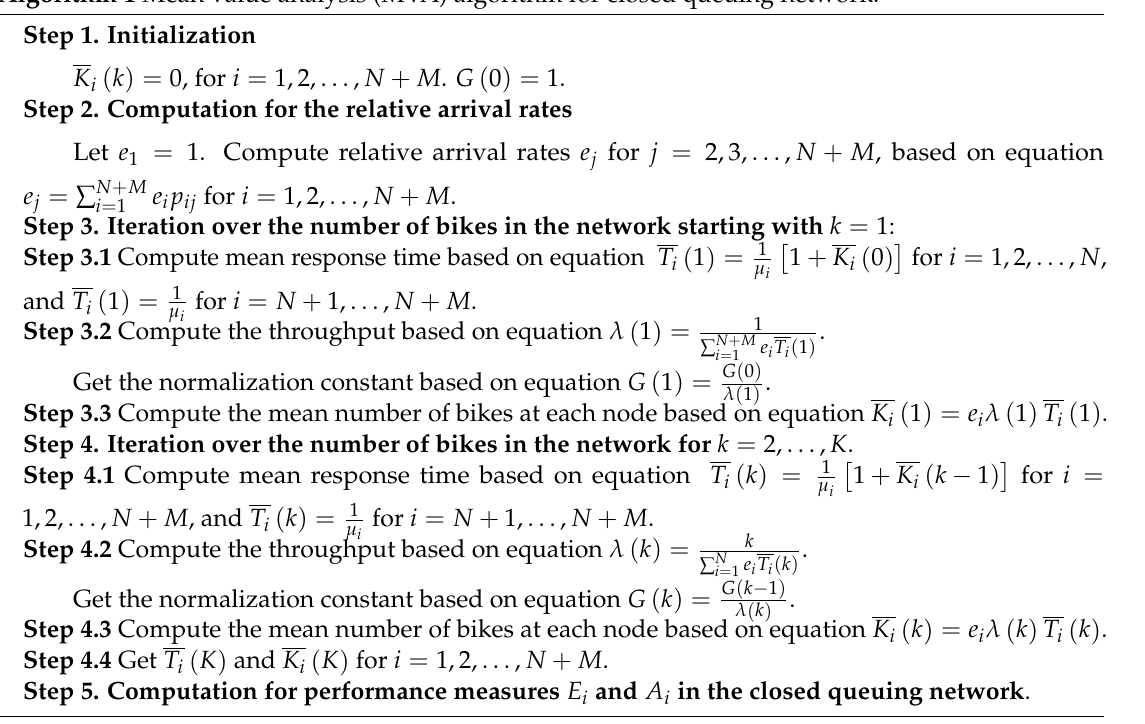
Algorithm 1 Mean value analysis (MVA) algorithm for closed queuing